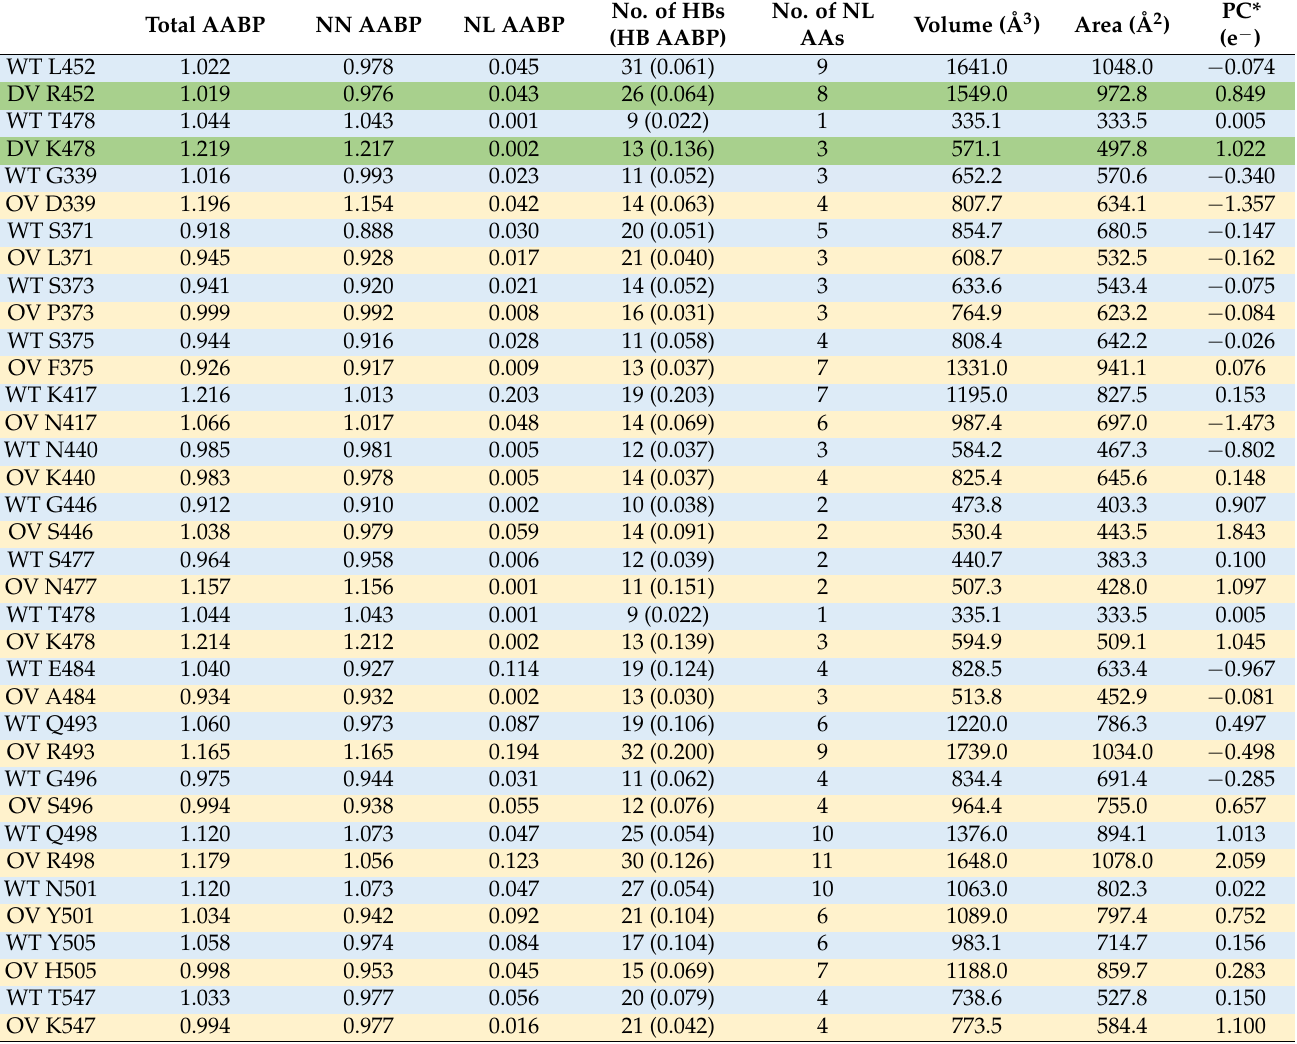
Table 1. Comparison of AABP units between wild type (WT), top 2 for Delta variant (DV) and 16 Omicron variant (OV) in RBD-SD1 domain. AABP is in unit of electrons (e −